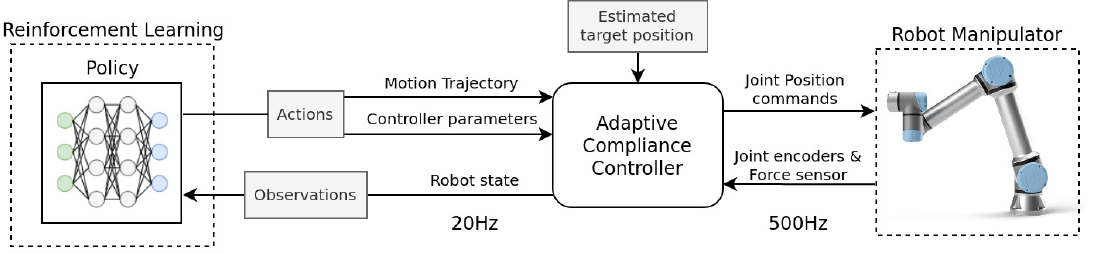
Figure 2. Our proposed framework. On the basis of estimated target position for an insertion task, our system learns a control policy that defines motion-trajectory and force-control parameters of an adaptive compliance controller to control an industrial robot